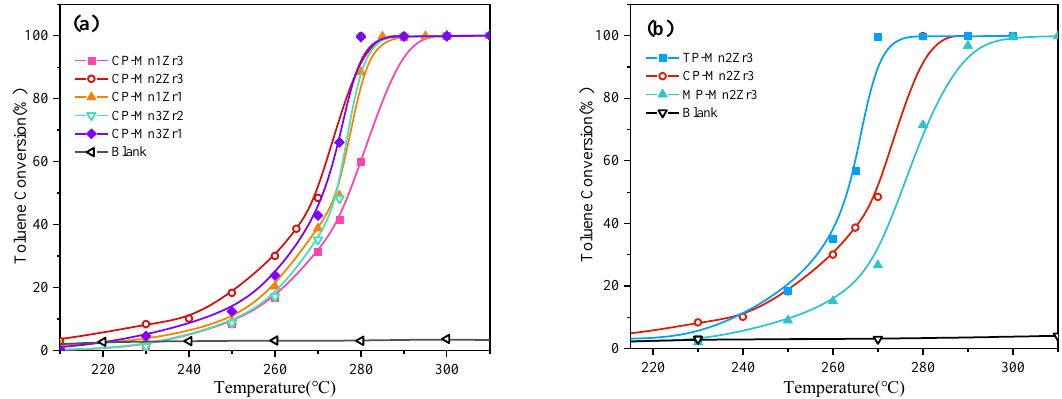
Figure 6. Activity test of catalysts with different molar ratios of Mn/Zr ( a ) and prepared by different strategies ( b ).